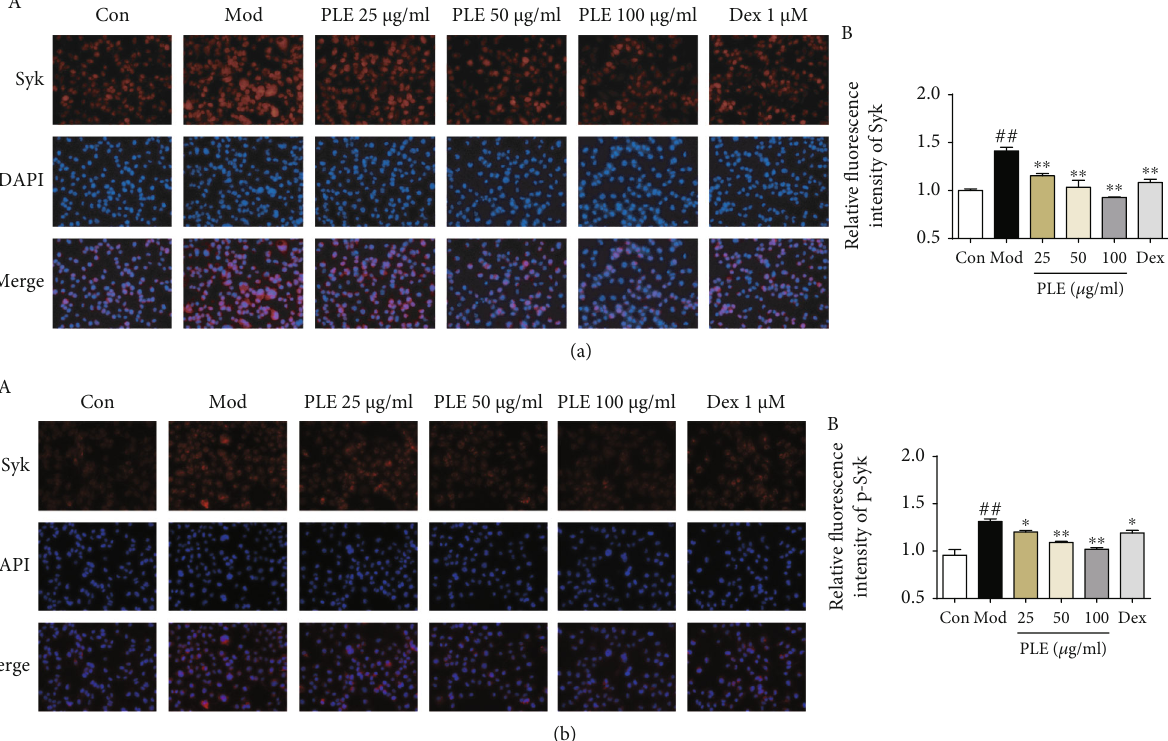
Figure 4: E ff ects of PLE on the expressions and phosphorylation of Syk in RBL-2H3 cells in vitro. (a) (A) The representative photomicrographs (magni fi cation, × 200) of Syk and (B) their relative fl uorescence intensity investigated by IF staining ( n = 3 ). (b) (A) The representative photomicrographs (magni fi cation, × 200) of p-Syk and (B) their relative fl uorescence intensity investigated by IF staining ( n = 3 ). ## P < 0 : 01 vs. control group; ∗ P < 0 : 05 and ∗∗ P < 0 : 01 vs. model